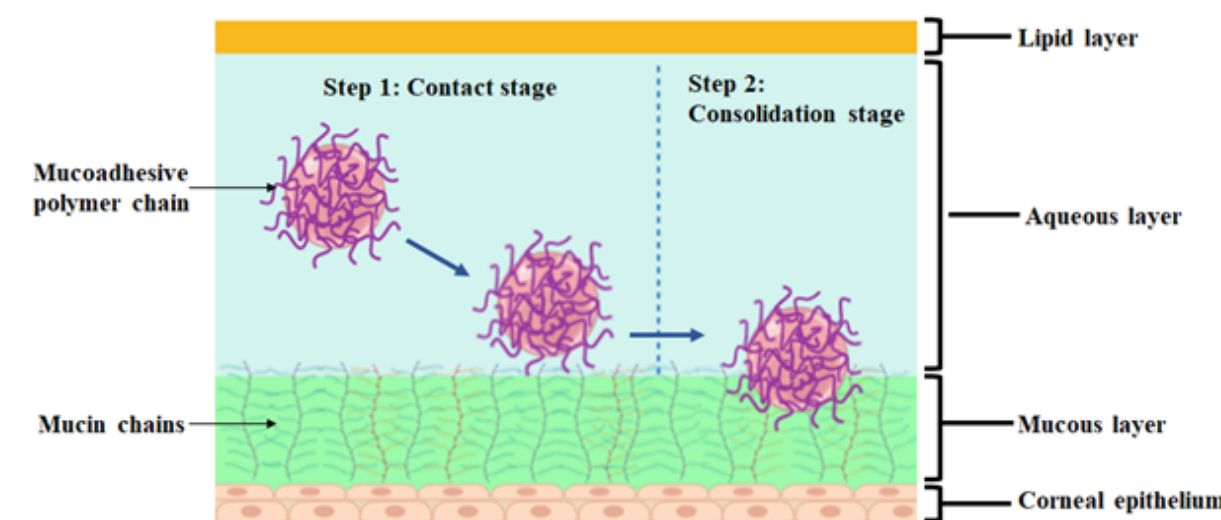
Figure 1. Mucoadhesion involves two steps: a contact stage followed by a consolidation stage. In the contact stage (Step 1), wetting and swelling occur in the mucoadhesive formulation when the polymer spreads over the mucus membrane to develop a deep contact with the mucus layer [13,14]. Subsequently, the consolidation stage (Step 2) involves physicochemical interactions that establish and consolidate the adhesive interaction [15]. In this stage, the mucin chains entangle with the mucoadhesive polymer chains, resulting in mechanical bond formation [16,17]. Then, moisture’s presence promotes the formation of chemical bonds such as hydrogen bonds, covalent bonds, and weak van Der Waals forces that strengthen the system [13,16].